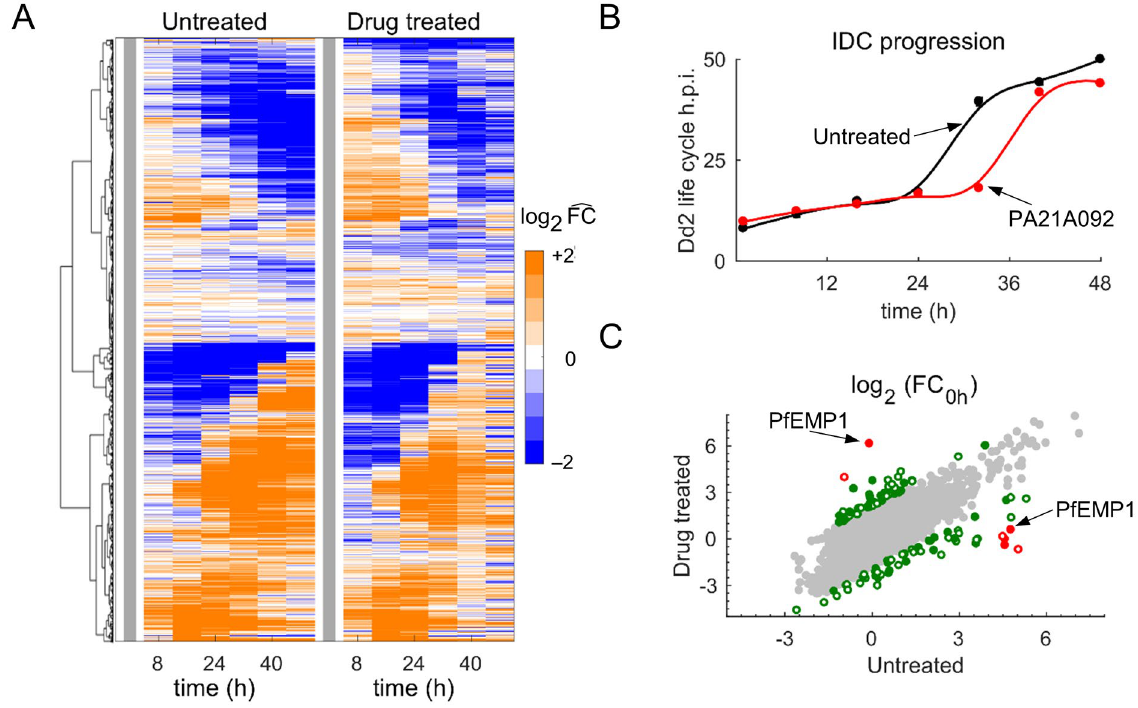
Figure 2. Global analysis of transcriptomic data from untreated and pyrazoleamide-treated P. falciparum . ( A ) Hierarchical clustering analysis of transcriptomic data from the untreated and treated parasites. Each row corresponds to a parasite gene, and each column represents a sampled time point of the intraerythrocytic development cycle (IDC). The gene-expression level, under a given perturbation (untreated or drug treated), at a particular time point represents the average of four technical replicates. To facilitate inter-study comparisons, we normalized temporal expression of each gene by its 0-h expression value (vertical gray bars). The untreated and drug-treated parasites appear to have similar expressions during the IDC, indicating a lack of alteration in the parasite’s gene-expression program due to drug treatment. ( B ) IDC progression of untreated and drug- treated parasites. To quantify IDC progression, we computed the Pearson correlation between gene-expression profiles of each replicate from this study and those from the hourly sampled data of Llinas et al. 13 . The closed circles denote the mean of maximum correlation between the two datasets (untreated or treated) at the time points indicated on the x -axis. ( C ) Average fold change in gene expression relative to its expression at 0 h (FC 0h ) in untreated and drug-treated parasites. Plasmodium genes shown with red circles have fourfold (log 2 scale) different FC 0h after treatment as compared to untreated conditions, while genes shown with gray circles have a less than twofold (log 2 scale) difference; all other genes are shown using green circles. The open and closed circles denote genes with unknown and known (or putative) functions, respectively. h.p.i. hour post infection, PA21A092 a pyrazoleamide drug, PfEMP1 Plasmodium falciparum erythrocyte membrane protein 1.